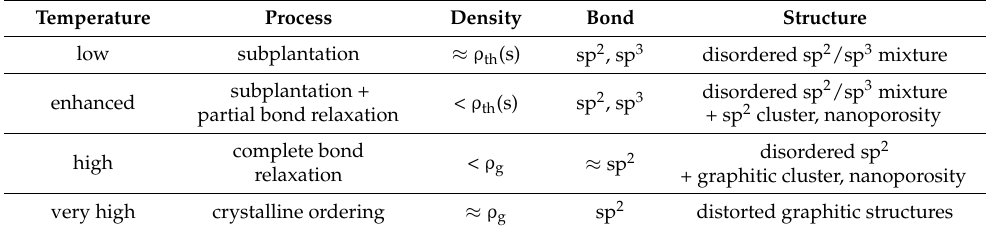
Table 4. Classification of carbon films, deposited by vacuum arc discharges at various temperatures.